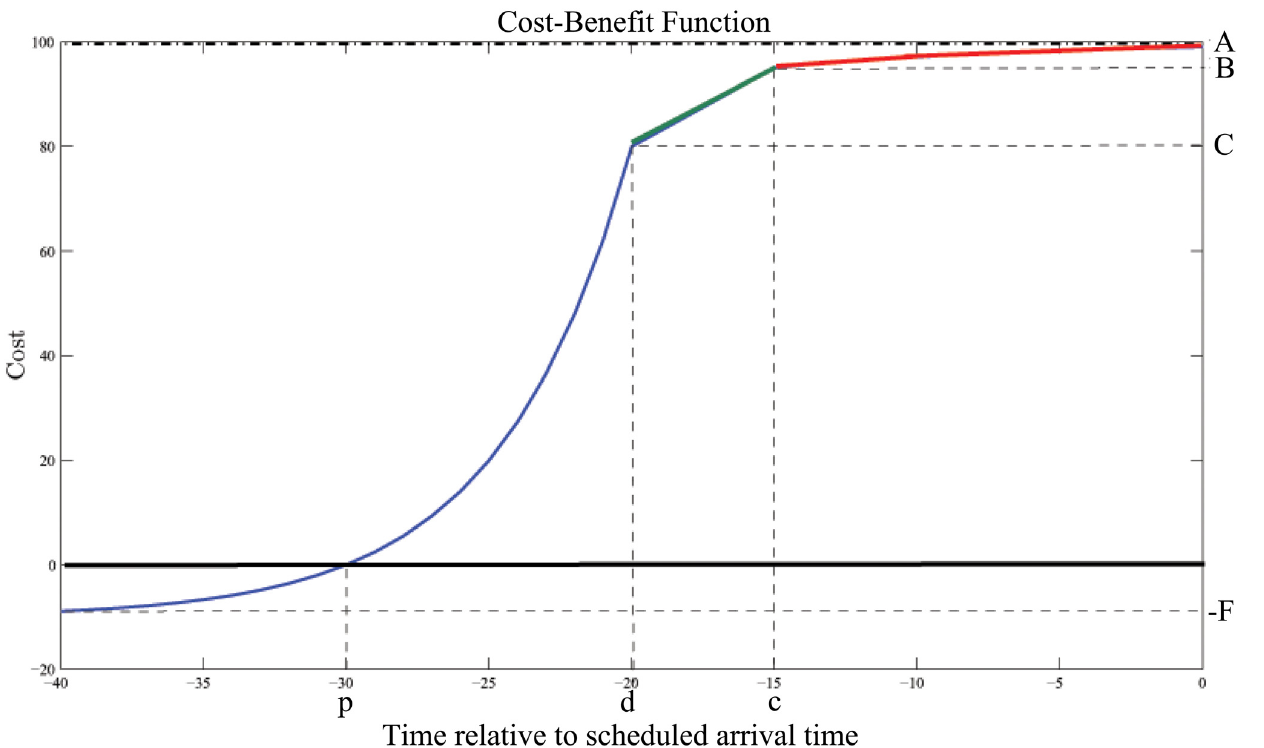
Fig 4. The Cost-Benefit Curve for Scenario